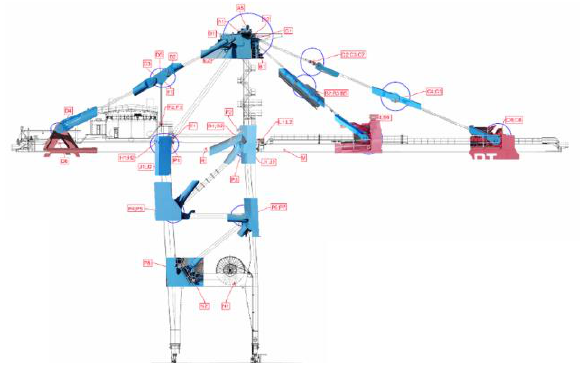
Figure 5 . Schematic view of one crane bridge from crane type (ZMPC) with 13 neuralgic/critical